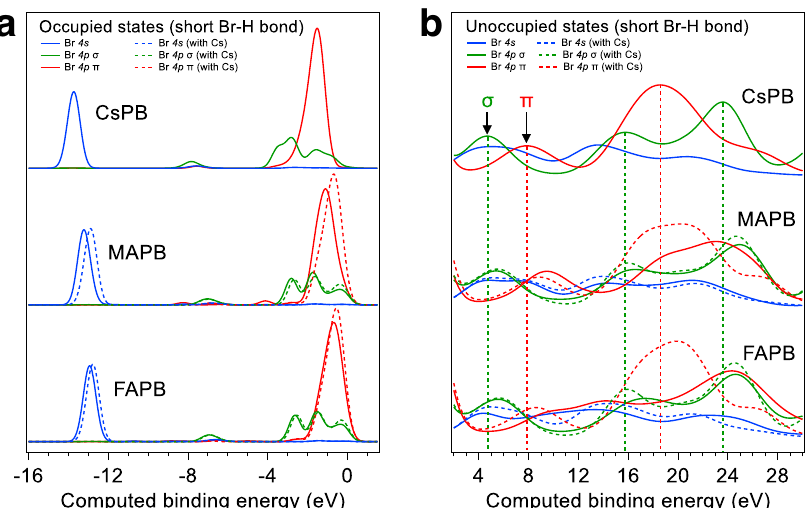
Fig. 3 Calculated ground-state bromine 4 s , 4 p σ and 4 p π projected density of states of CsPB and strongly hydrogen-bonded FAPB and MAPB. a Occupied states are enumerated with negative binding energies and are Gaussian-broadened by 0.3 eV. The top of the valence band is aligned to 0 eV binding energy. b Unoccupied states are Gaussian-broadened by 1.0 eV to emphasize the main features of interest. The two π components have been averaged together to yield one Br 4 p π distribution. Projected density of states (PDOS) corresponding to strongly hydrogen-bonded bromine with organic molecules are shown. Bromine PDOS associated with cesium-substituted MAPB/FAPB are shown with dashed lines. The vertical dashed lines are guides to the eye and mark CsPB features of interest which can be compared to similar features for original and cesium-substituted MAPB and